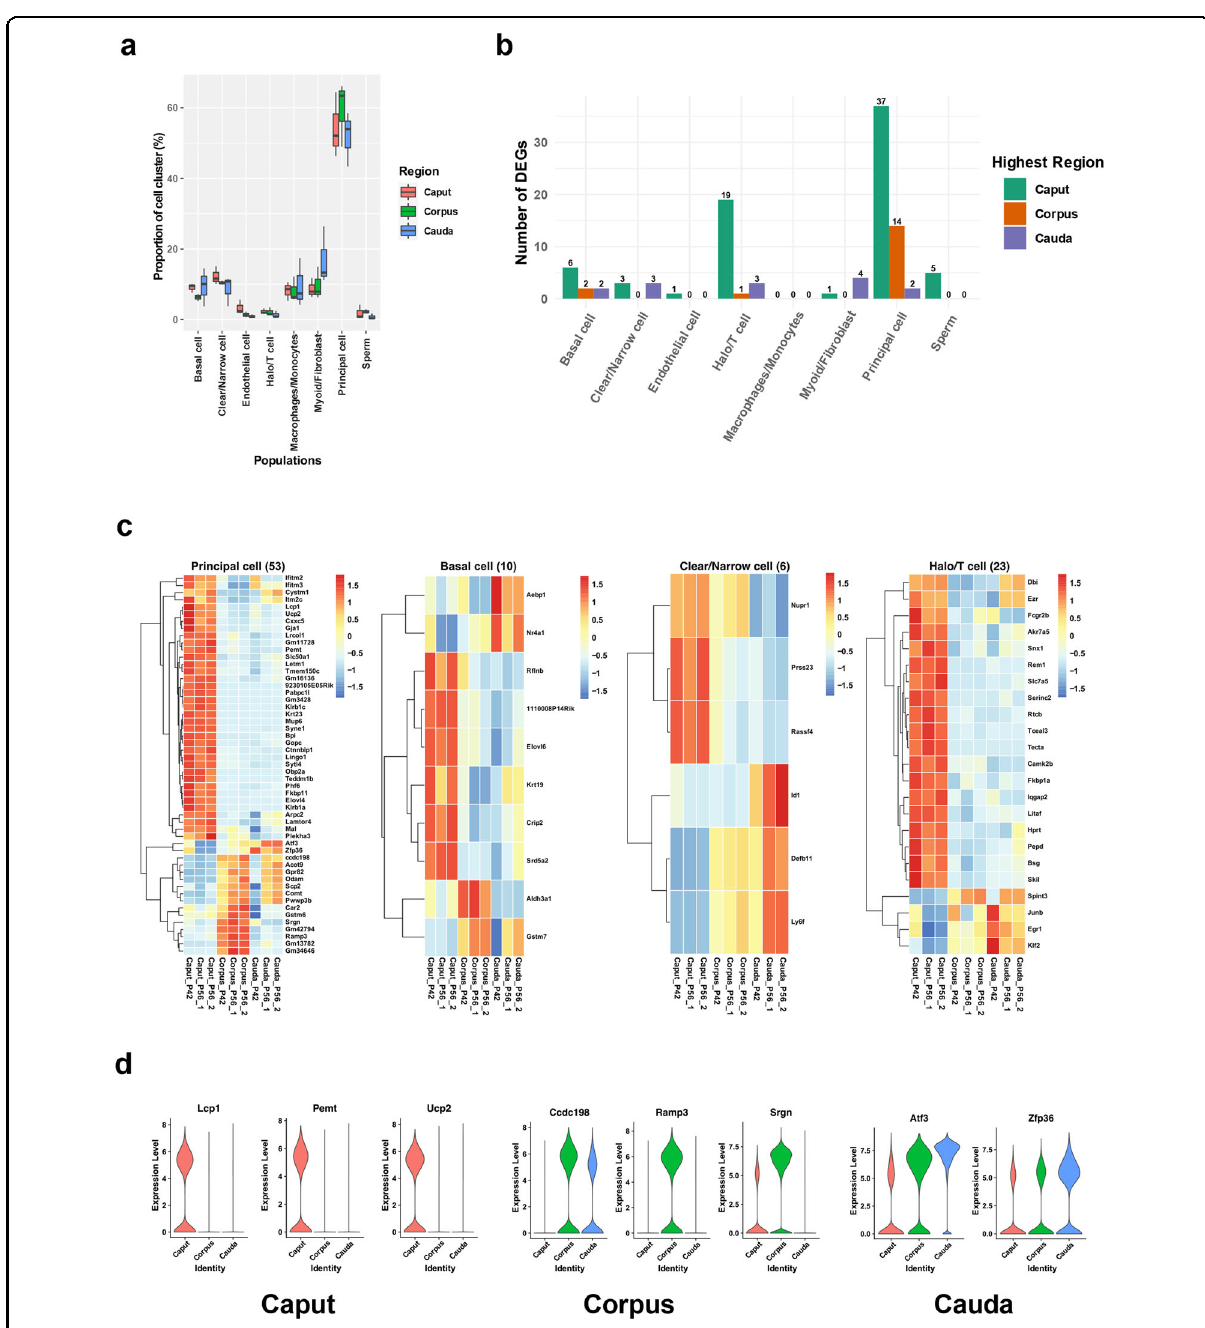
Fig. 3 Segmental DEGs of the mouse epididymis. a The spatial proportion of each cell cluster is illustrated. b The distribution of the number of segmental DEGs in each cell cluster. c Heatmaps of DEG comparisons in three epididymal regions from the epididymal epithelial cell clusters (log1pRPM scaled by row). d Representative spatially speci fi c DEGs of principal cells in three epididymal segments ( y -axis